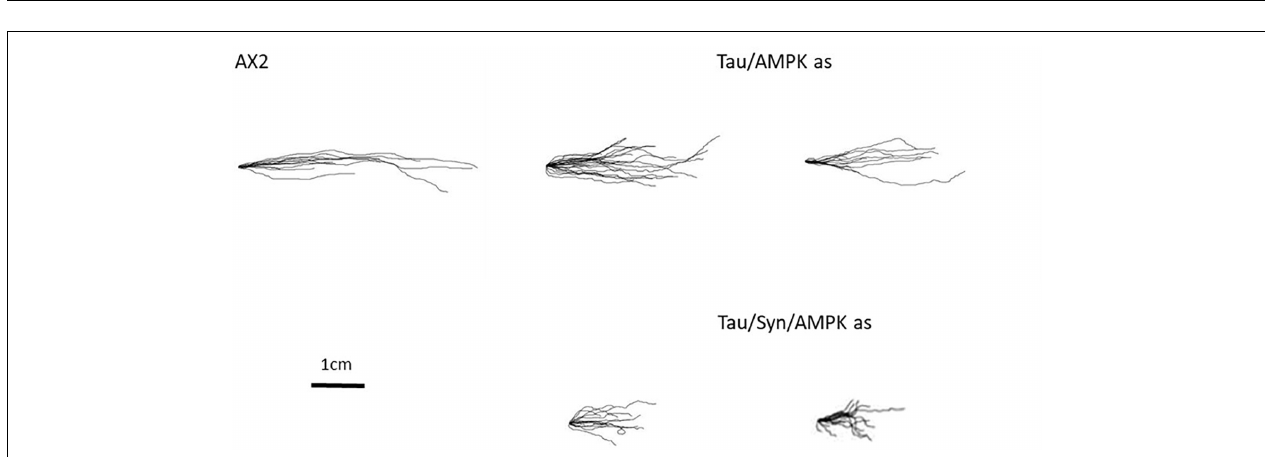
FIGURE 5 | Legionella proliferation is increased in tau and cotransformant strains. Legionella infection rates were measured by creating a monolayer of D. discoideum amoebae in a cell culture plate and infecting these with L. pneumophila Corby. The parental strain AX2 (WT), tau expressing strains (TAU), α -synuclein expressing strains (SYN), and cotransformants expressing tau and α -synuclein (CO) were infected with L. pneumophila and assayed for viable counts across five days at time periods 0, 24, 48, 72, and 96 h. Extracellular L. pneumophila was killed by the addition of Gentamycin sulphate (G418) 30 min before cells were harvested for viable counts. (A) The normalised viable counts resulting from the intracellular L. pneumophila released by the D. discoideum cells were plotted against the corresponding time periods. A negative control was included for comparison and did not contain D. discoideum cells. L. pneumophila proliferation was increased in tau and co-transformant strains when compared to AX2. The plot values are an average of 3–6 strains per time period and were assayed in at least three individual experiments. The error bars are standard errors of the mean. (B) The maximum L. pneumophila proliferation rates were normalised to the proliferation in AX2 (WT). L. pneumophila proliferation was significantly decreased in α -synuclein expressing strains compared to the WT. There was a significant increase in L. pneumophila proliferation in the tau and co-transformant strains in comparison to the parental strain. p -Values represent statistical significance using an ANOVA with pairwise comparisons using the Least Squares Difference test. Error bars are the standard errors of the mean.